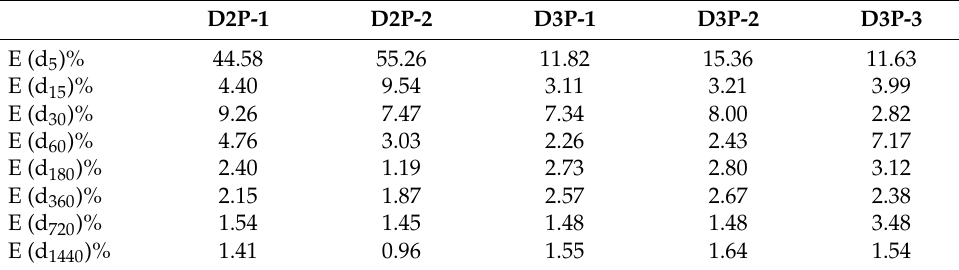
Table 2. Mean Absolute Percentage Error.